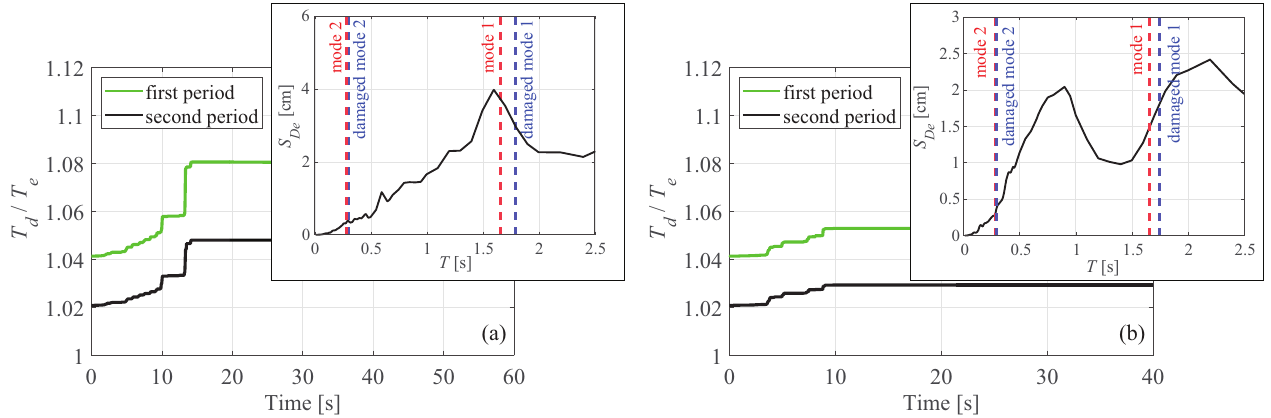
Figure 21. Time histories of first two periods of the damaging equivalent pier under ( a ) ALT and ( b ) T1212